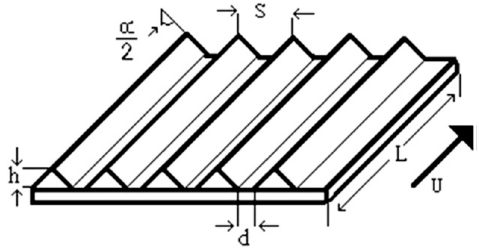
Figure 15. Configuration of rib ‐ let, Chamorro et al. [169].